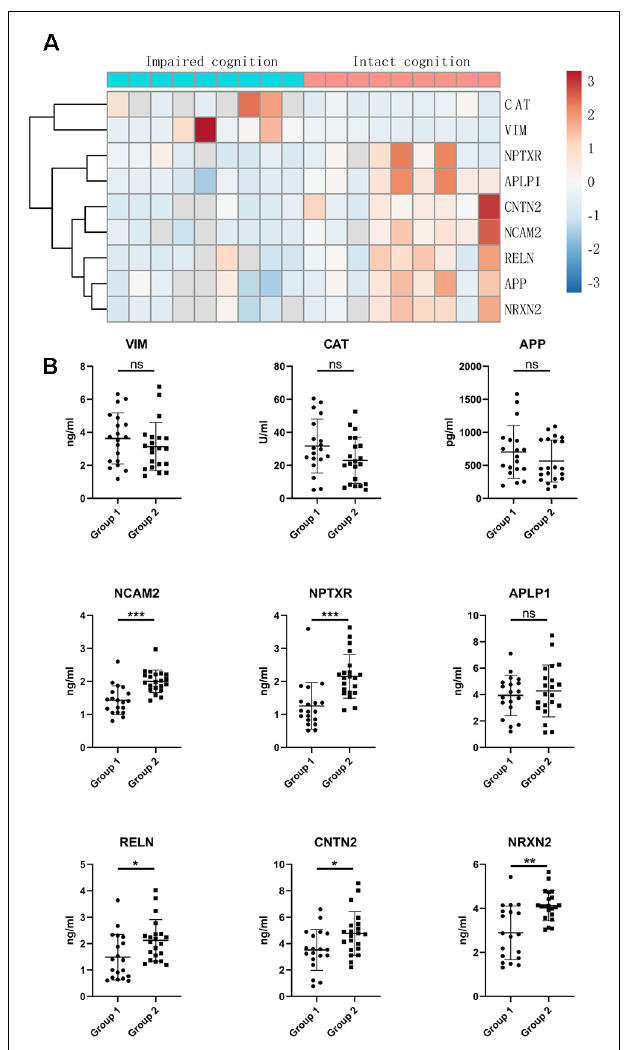
FIGURE 3 | Validation of candidate proteins in the CSF of aSAH patients by ELISA. (A) Heatmap of candidate proteins that significantly differed between the two groups. (B) CSF levels of the candidate miRNAs in the impaired cognition group ( n = 19) compared to the intact cognition group ( n = 21). Group 1: impaired cognition; Group 2: intact cognition; ns, not significant; asterisks refer to statistically significant differences with T test, * p < 0.05; ** p < 0.01; *** p < 0.001.